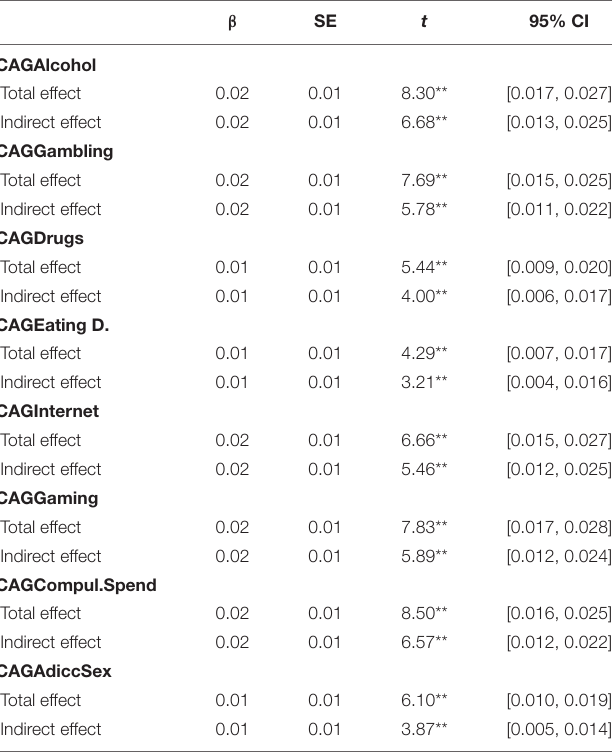
TABLE 4 | Mediation model that includes emotional dependence (X), intimate partner violence (M), and addictive behaviours (Y). β SE